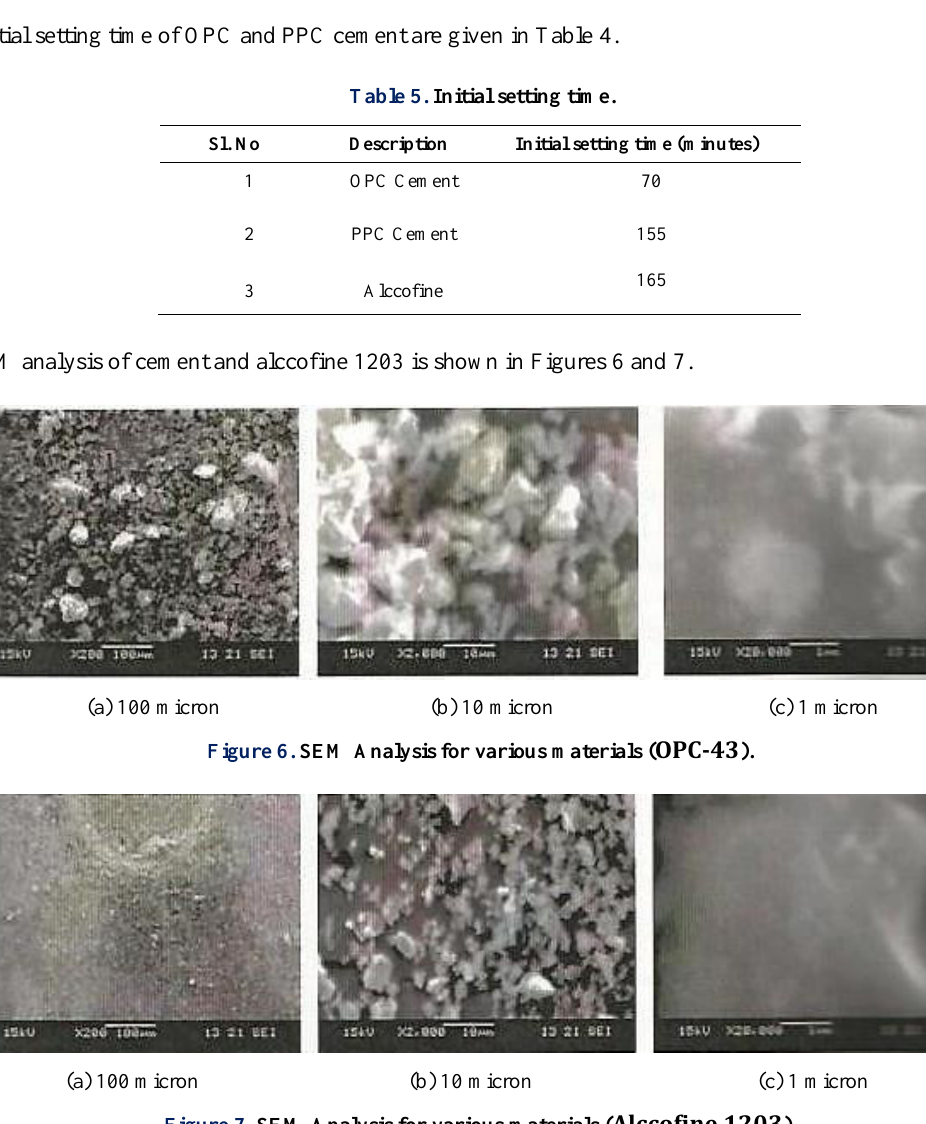
Figure 7. SEM Analysis for various materials ( Alccofine 1203